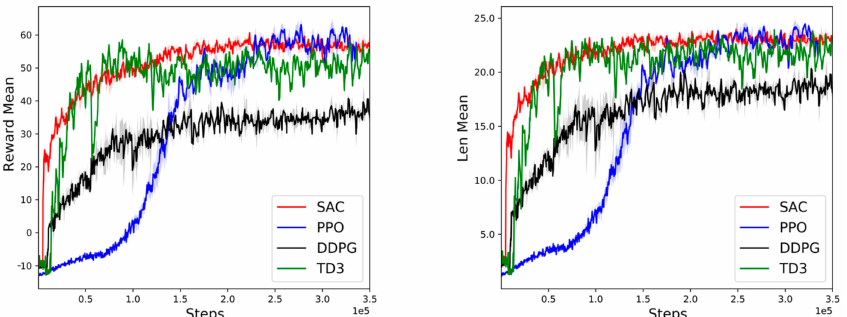
Figure 8. The reward curves and learning curves on reinforcement learning hierarchical framework for using SAC algorithm. We stopped training when the parameters were stable. The abscissa represents the number of steps and the ordinate represents the return value (the average epoch length is on the left and the average epoch reward on the right). Our framework learned the gait strategy and converged